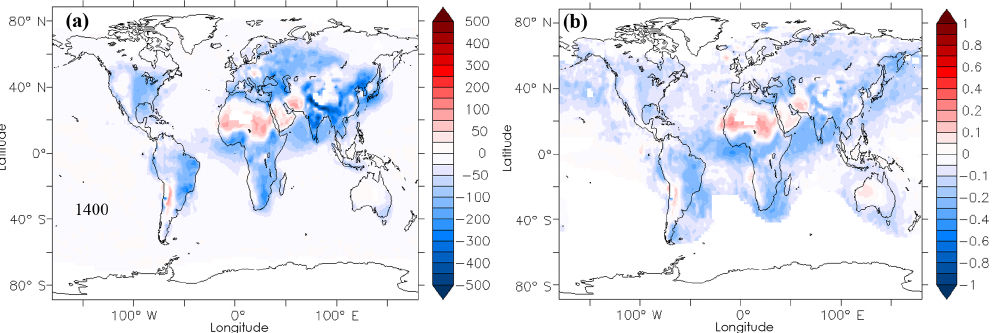
Figure 8. (a) Absolute (in cm − 3 ) and (b) fractional annual average change in the predicted CDNC (at the lowest cloud-forming level, 940hPa) by switching on/off the FHH adsorption activation physics. A positive change corresponds to an increase from water adsorption on mineral